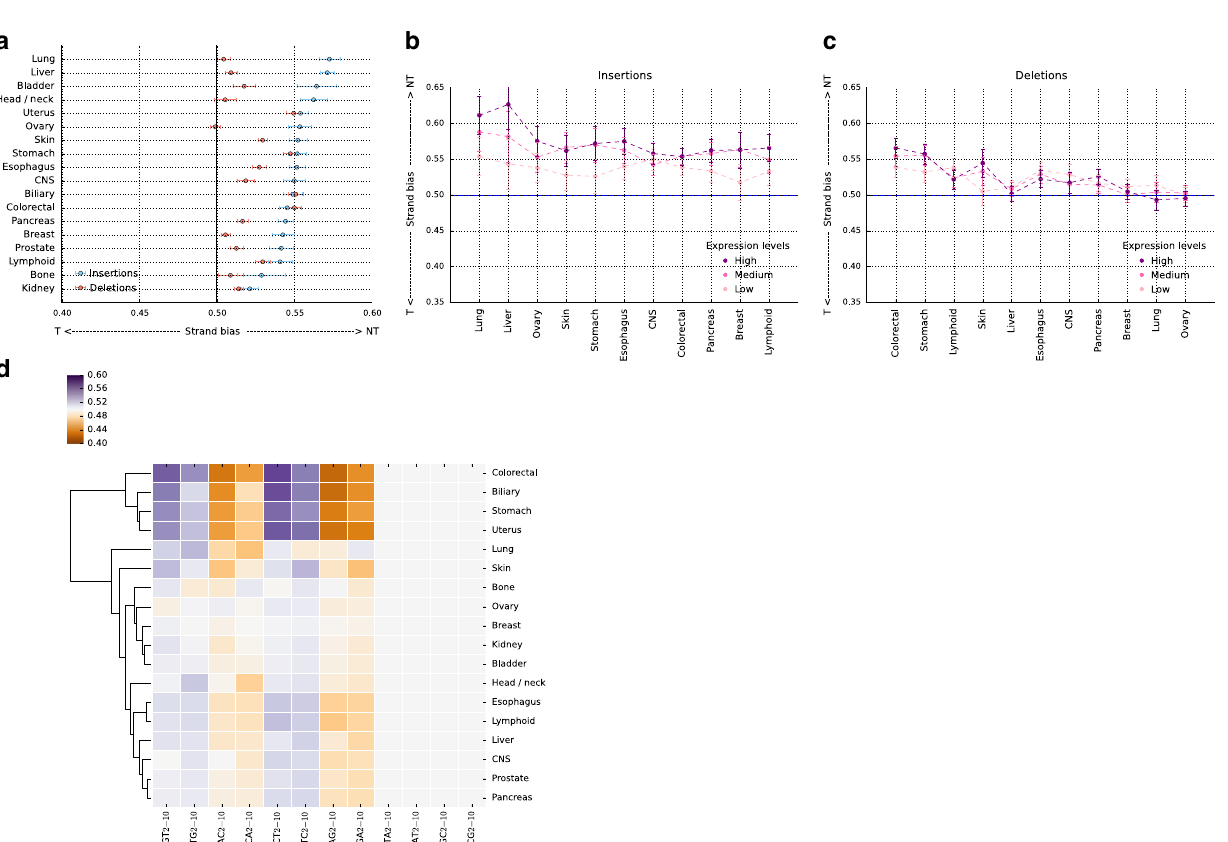
Fig. 4 Transcriptional strand asymmetry at insertions and deletions. a Transcriptional strand asymmetry of insertions and deletions at polyT tracts. Error bars represent standard deviation from bootstrapping with replacement. Both insertions and deletions displayed a strand asymmetry bias towards the non- template strand for polyT tracts across cancer types (binomial test with Bonferroni correction, p value < 0.001 for insertions and p value < 0.05 for deletions). b Transcriptional strand asymmetry occurring at polyT tracts according to level of gene expression for insertions. Mann – Whitney U with Bonferroni correction, p value < 0.001 when comparing low and high expression gene sets across all cancer types except skin, ovarian and lymphoid cancers ( p value < 0.05) and CNS ( p value > 0.05). c Transcriptional strand asymmetry occurring at polyT tracts according to level of gene expression for deletions. Mann – Whitney U with Bonferroni correction, p value < 0.001 when comparing low and high expression gene sets for skin and p value < 0.05 for stomach and pancreatic cancers. d Hierarchical clustering displaying transcriptional strand asymmetries for indels overlapping dinucleotide motifs. Dinucleotide repeat tracts of up to fi ve repeated units are displayed. Purple represents asymmetry towards the non-template strand, whereas orange represents asymmetry towards the template strand. In the dendrogram of cancers, biliary, uterus, colorectal and stomach cancers are more distant from the other cancers, and contain MSI samples, while lung cancers are also separable from other cancer types, further reinforcing our observations regarding the DNA damage and repair processes that contribute to the observed asymmetries. Across cancer types a non-template strand asymmetry preference was observed for TG, TC and CT motifs (binomial test with Bonferroni correction, p value < 0.001) and for GT motifs (binomial test with Bonferroni correction, p value < 0.05) and a template strand asymmetry for CA, GA and AG motifs (binomial test with Bonferroni correction, p value < 0.001) and for AC motifs (binomial test with Bonferroni correction, p value <